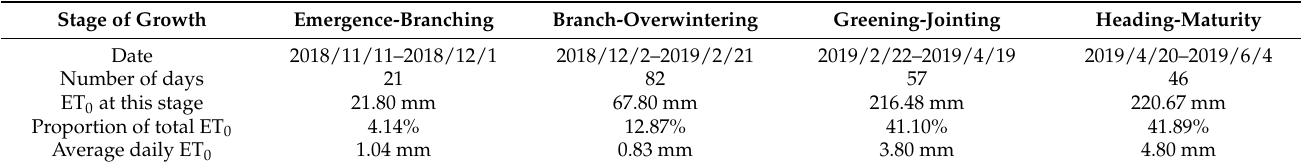
Table 1. Growth stage division of winter